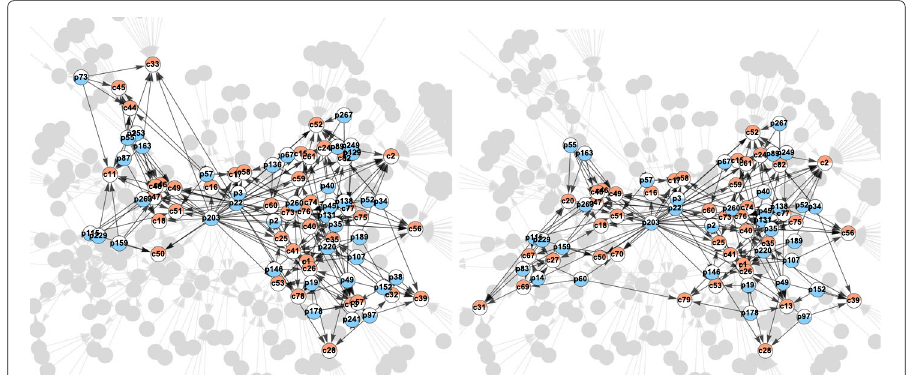
Fig. 5 Two 3-4 HA bi-concept extents from the experiments on the Participant-Campaign two-mode network. On the left the first bi-pattern select campaigns (prefixed with ’c’ and red-colored) whose main objective is the faunistic inventory while on the right the second bi-pattern select campaigns that satisfy various constraints in particular about the species described during the